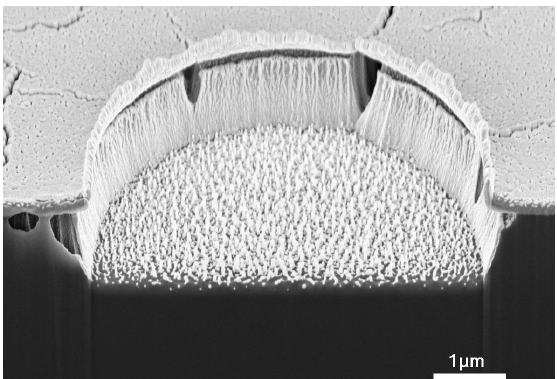
Figure 7. ICP etching of fully cured PI under 2500 W ICP power, 500 W RF power, 7% CHF 3 ratio, 100 sccm gas flow, and 0.5